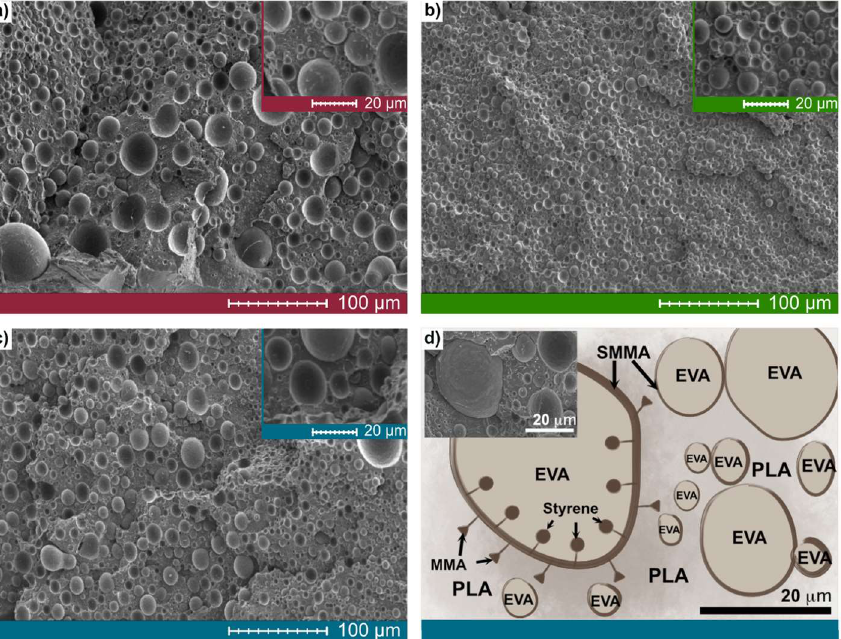
Figure 2. SEM micrographs of ternary blends. ( a ) EPS 1; ( b ) EPS 2; ( c ) EPS 3; ( d ) proposed model for EPS 1, EPS 2, and EPS 3 blends of all-phase coexistence.